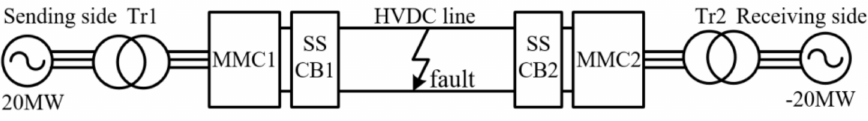
Figure 1. System